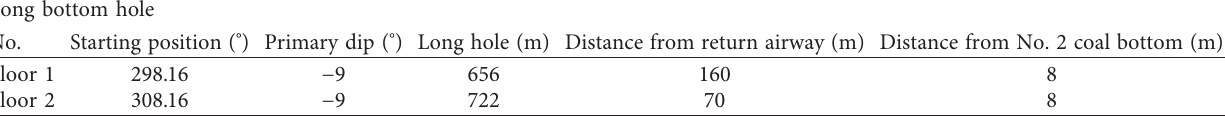
Table 4: Design parameters of three-dimensional pumping directional